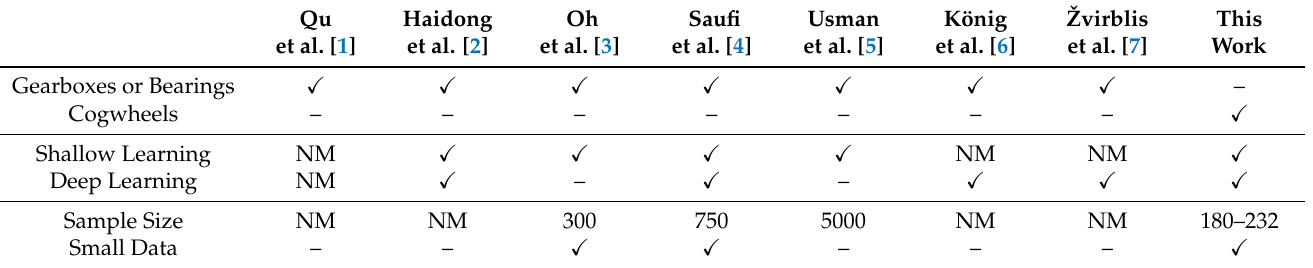
Table 1. Comparison of gearboxes, bearings, and cogwheels related work, where NM stands for “not mentioned. The symbols “ (cid:88) ” and “–” denote “being affirmative” and “not applicable”,